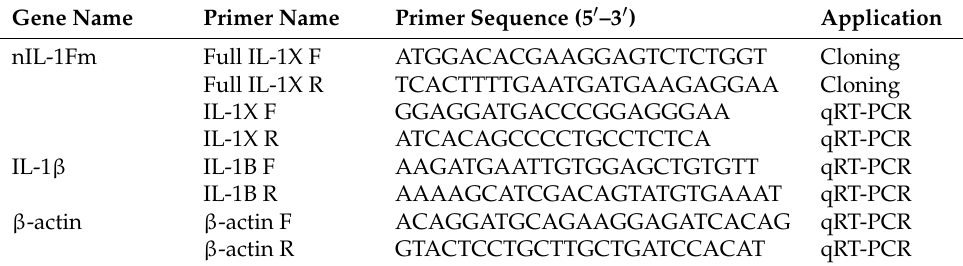
Table 1. Set of primers used in this